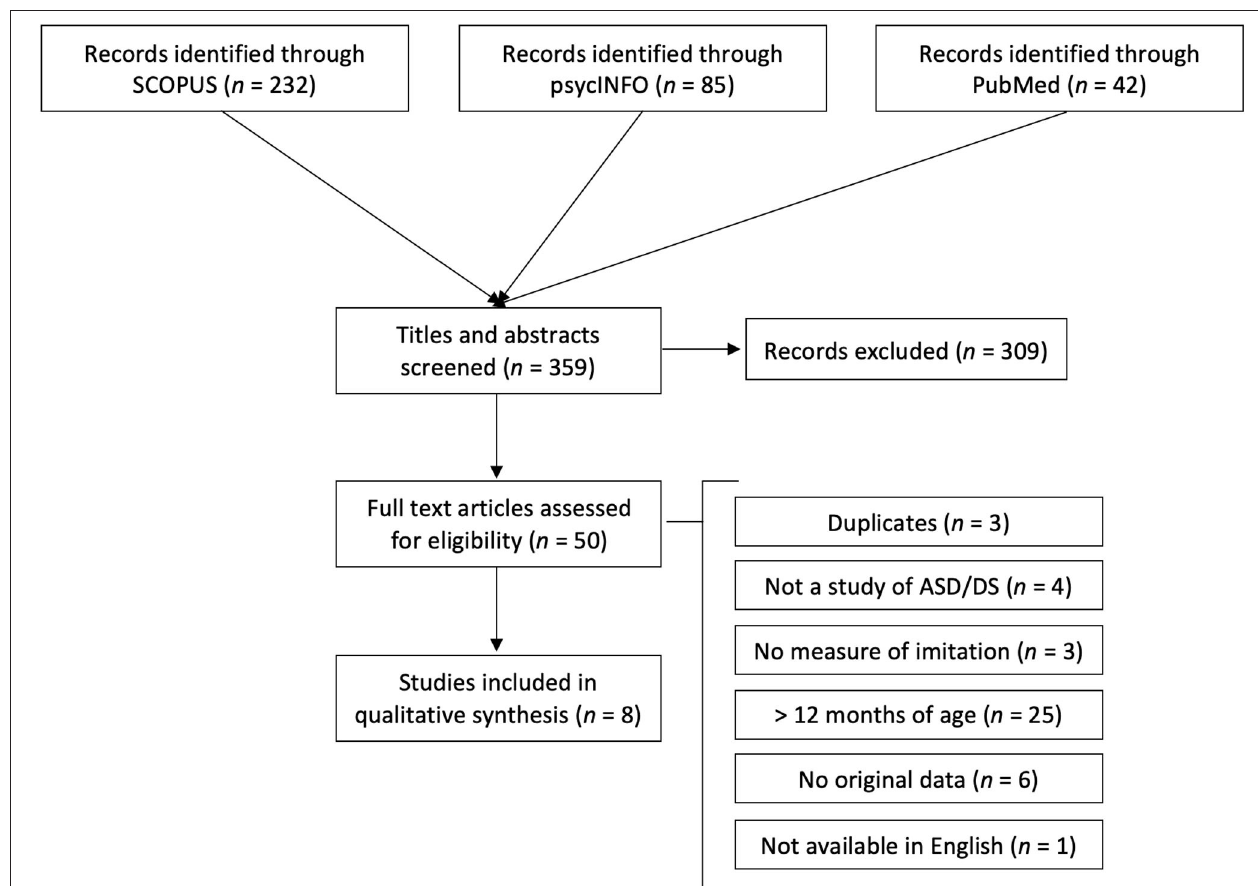
FIGURE 2 | Flow diagram of the literature